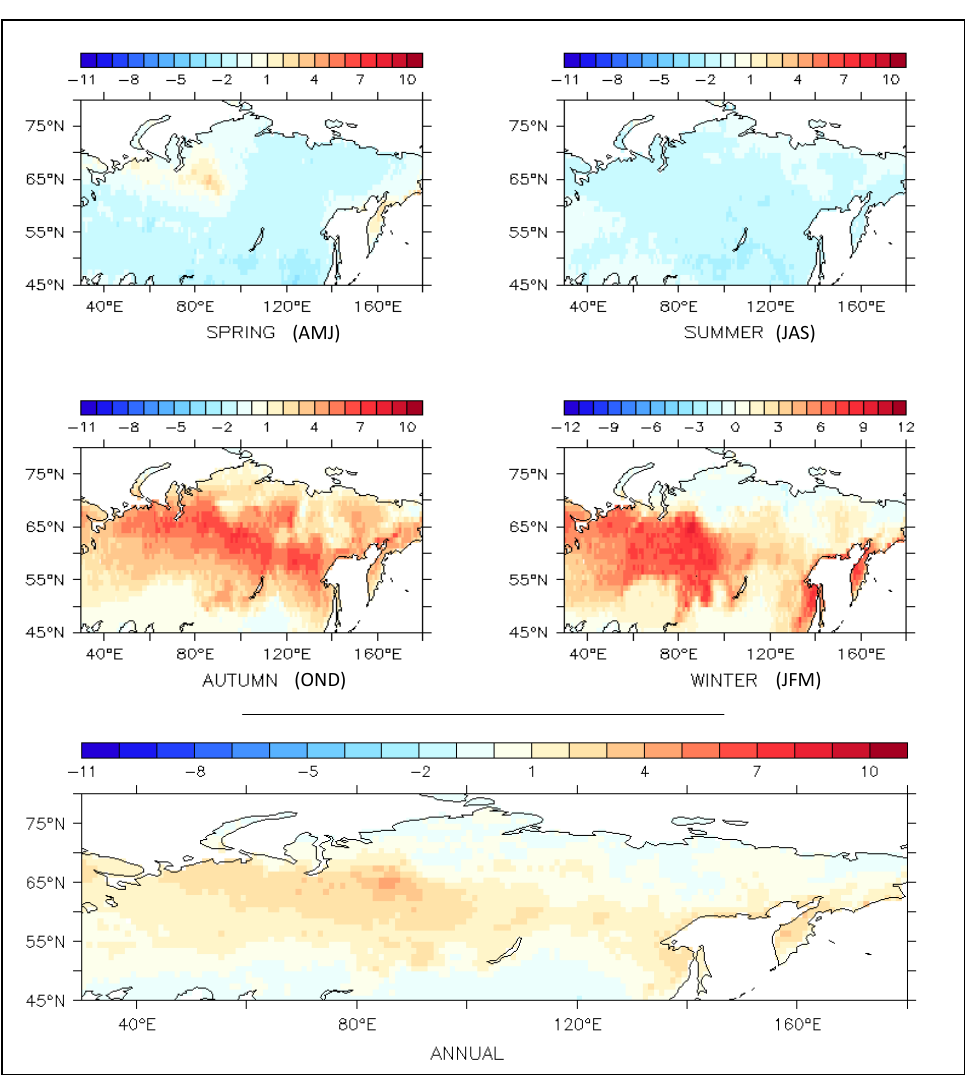
Fig. 7. 20cm soil temperature difference between the model with and without the new soil freezing scheme. Top: seasonal averages over the (1984–2000) period. For each season, the averaged months are mentioned by their initial in brackets. Bottom: annual average over the (1984–2000)